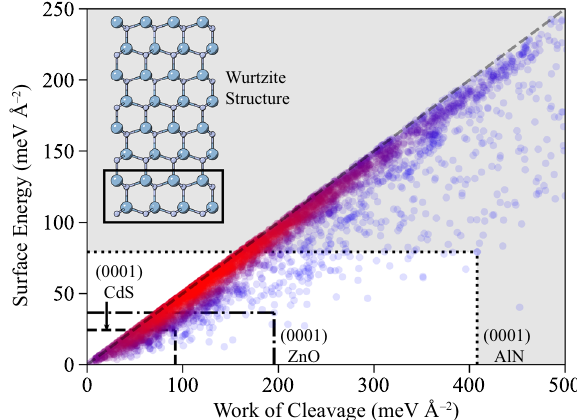
Fig. 3 The work of cleavage and the surface energy after ten relaxation steps of the cleaved surfaces. Red indicates a higher density of points. The solid, dashed, and dotted black lines represent the work of cleavage of the (0001) CdS, ZnO, and AlN substrates, respectively. The grey region indicates materials have a work of cleavage greater than common